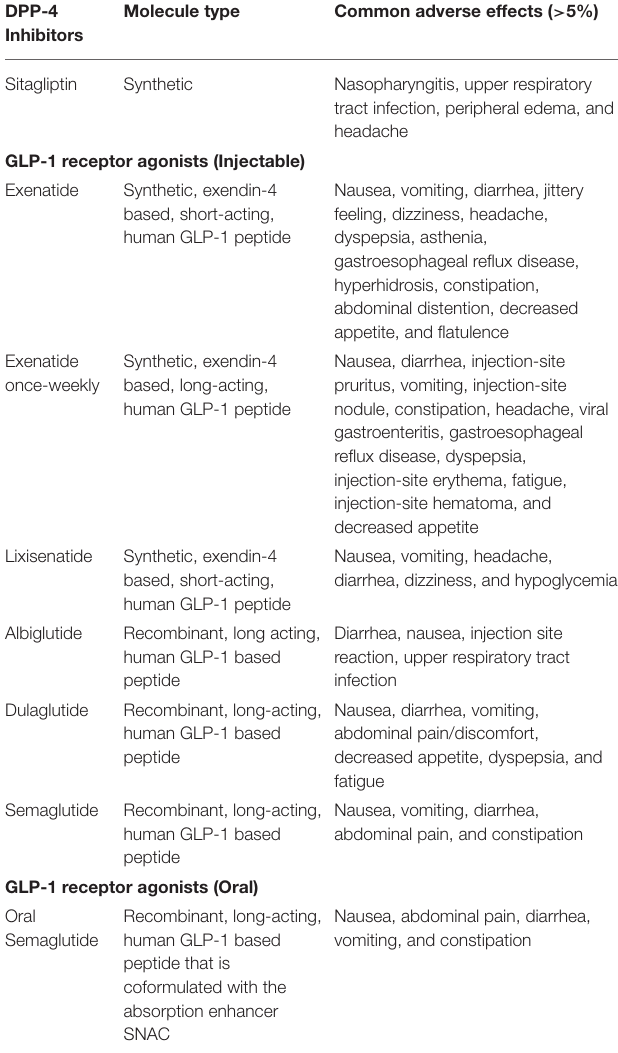
TABLE 2 | Comparison of molecule type and common adverse effects of GLP-1RA vs.